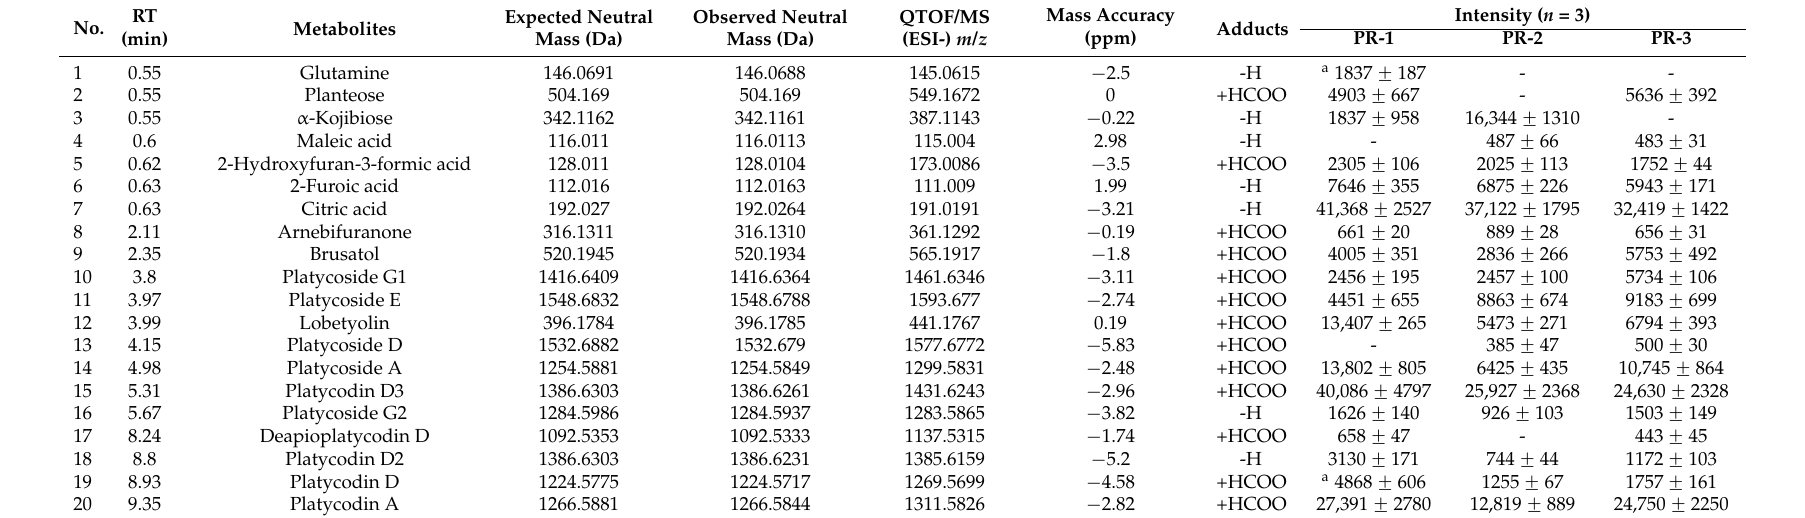
Table 3. List of metabolites analyzed in P. grandiflorum root